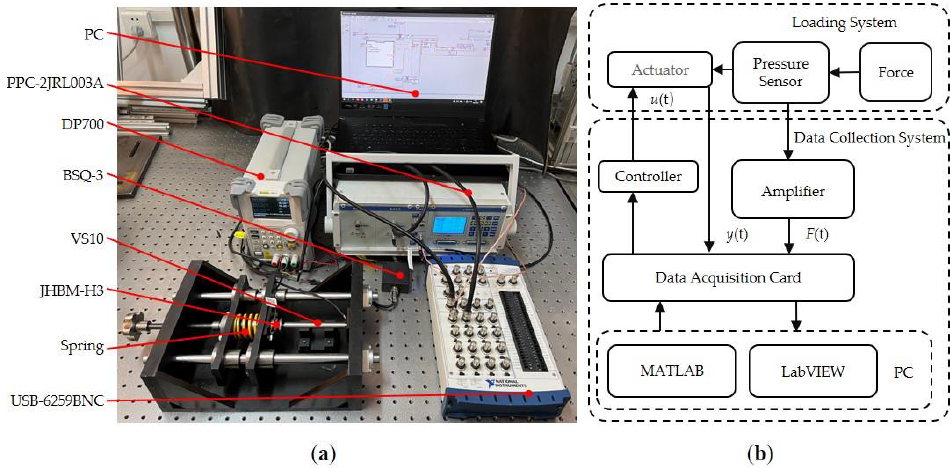
Figure 1. Experimenting Setup: ( a ) experimental equipment; ( b ) data acquisition system. Table 1. Compression spring performance parameters.